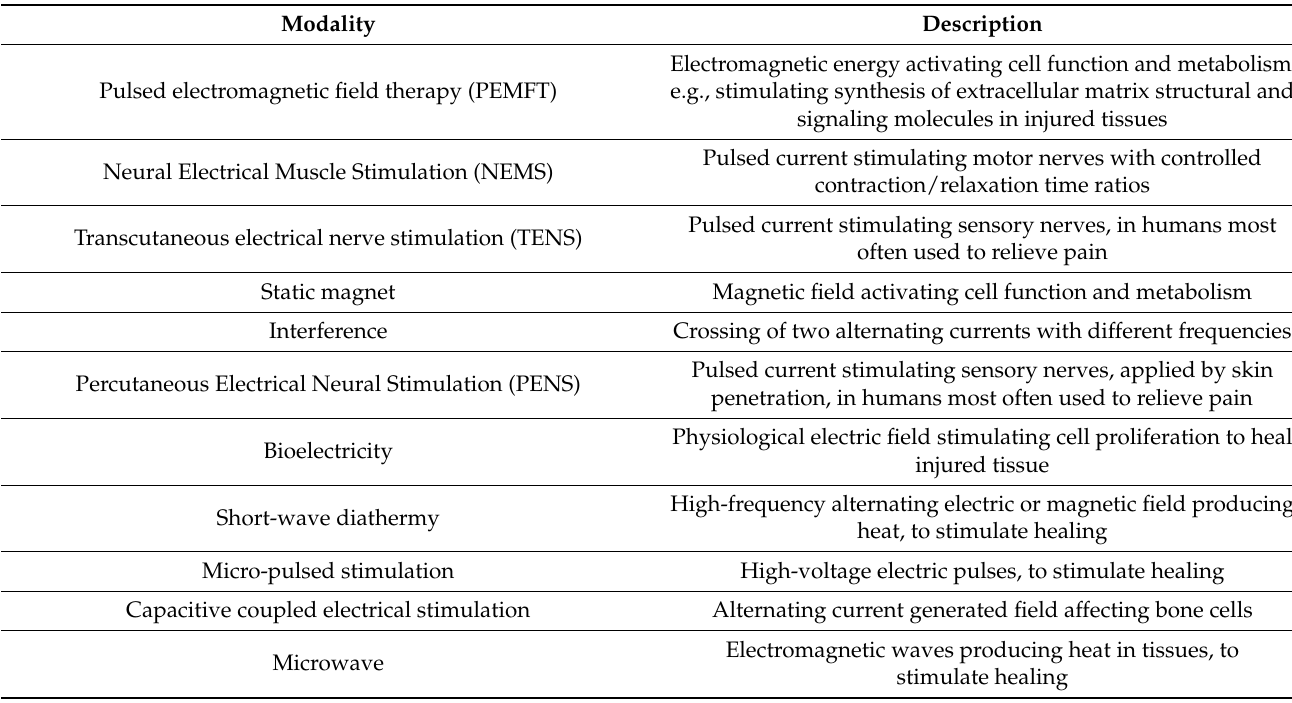
Figure 1. Flow diagram of the stages of the selection process used for identification of studies eligible for final analysis. Table 1. Electrotherapy modalities included in the review, with a short description of